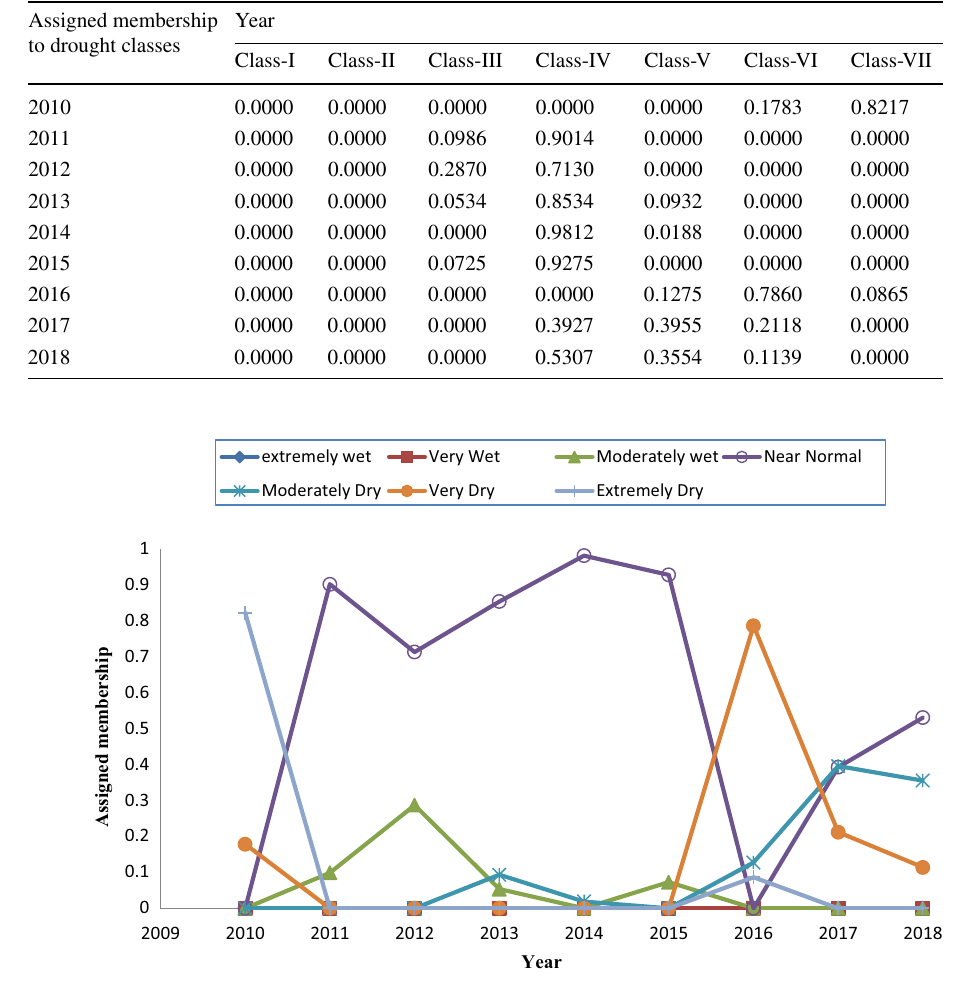
Table 2 Drought classification assigned by the Fuzzy -kNN model for the city of Kerman